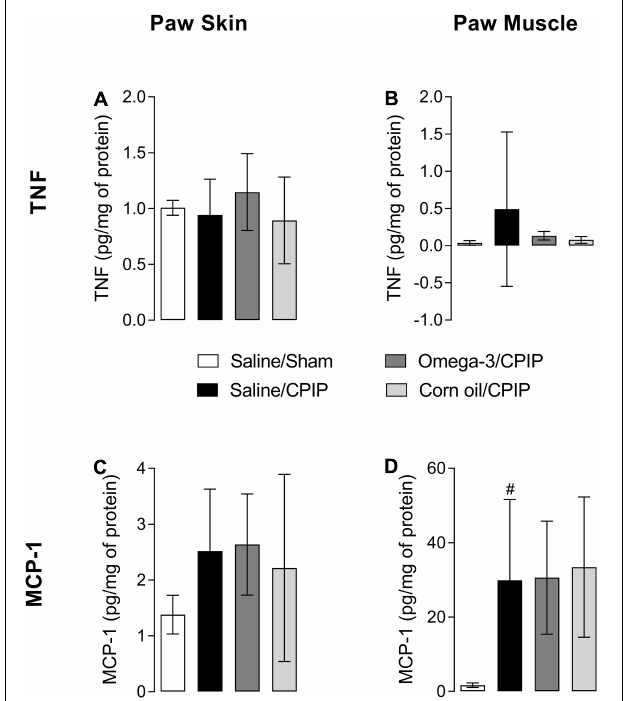
FIGURE 3 | Effects of omega-3 supplementation on tumor necrosis factor (TNF) and monocyte chemotactic protein-1 (MCP-1) concentrations in the paw skin and muscle of mice 48 h after the induction of the CPIP model. TNF concentrations in the skin (A) and muscle (B) of Saline/Sham, Saline/CPIP, Omega-3/CPIP, and Corn oil/CPIP groups. MCP-1 concentrations in the skin (C) and muscle (D) of Saline/Sham, Saline/CPIP, Omega-3/CPIP, and Corn oil/CPIP groups. Data are expressed as mean ± SD of 6–7 animals per group, statistically assessed by the one-way ANOVA followed by Tukey’s test. # p < 0.05 vs. the Saline/Sham